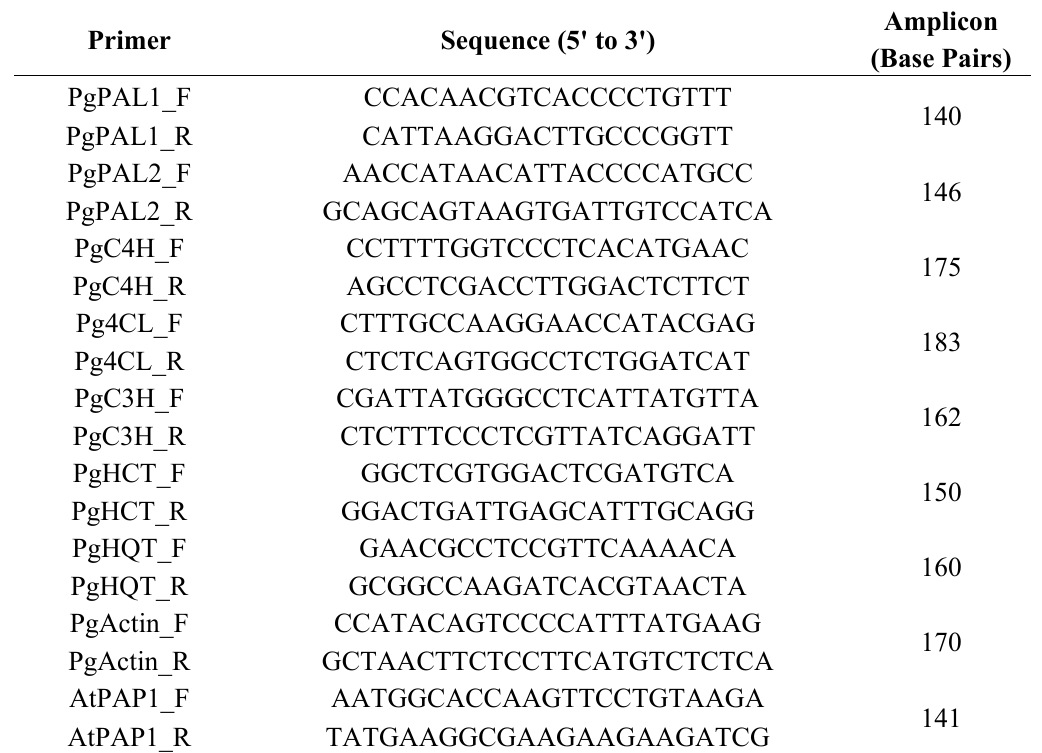
Table 1. Primers used for quantitative real-time